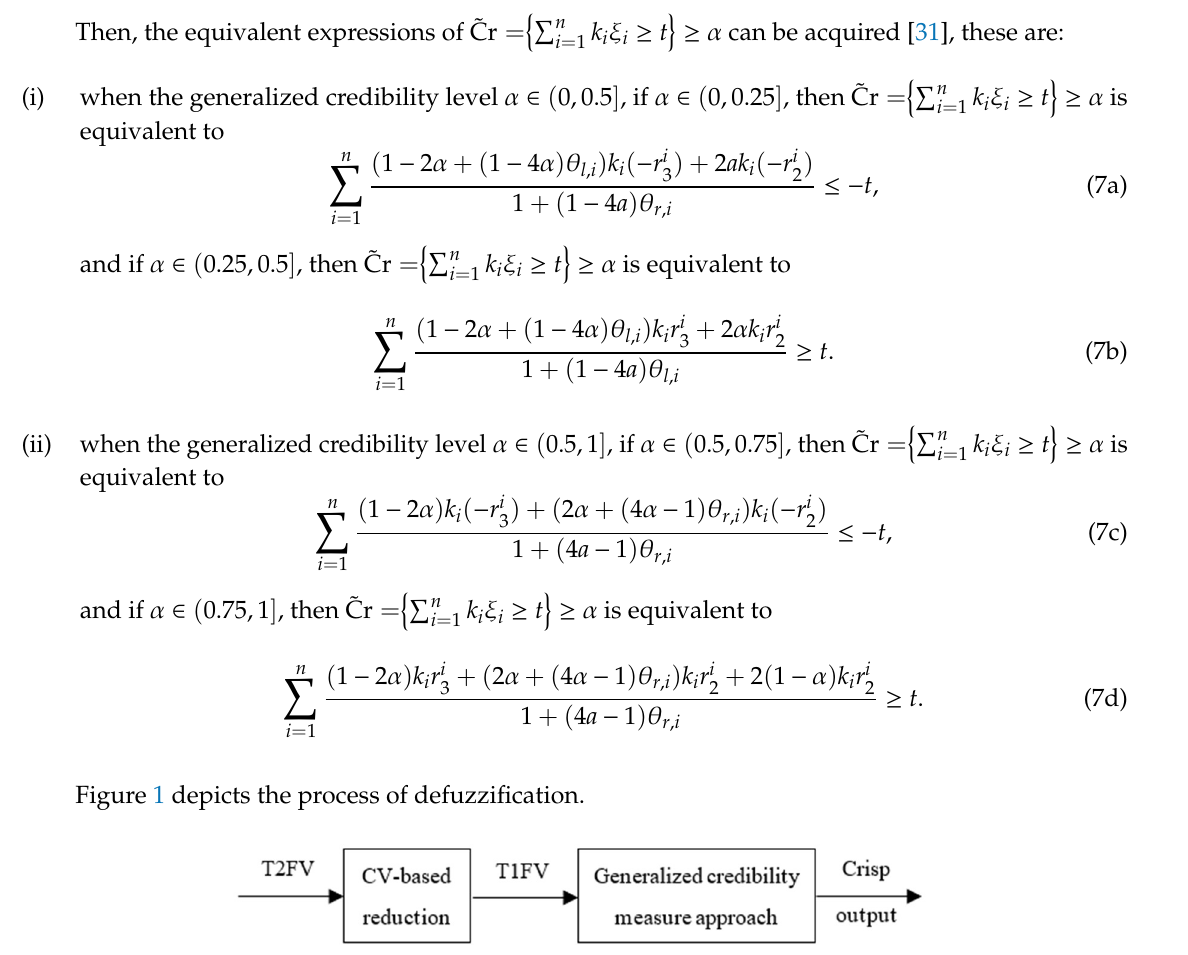
Figure 1. Defuzzification process of the type-2 fuzzy variable (T2FV).